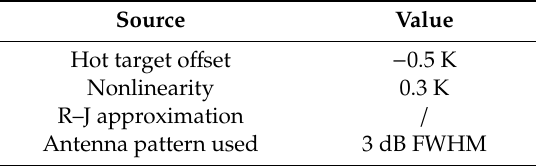
Table 4. Errors assumed for calibration.